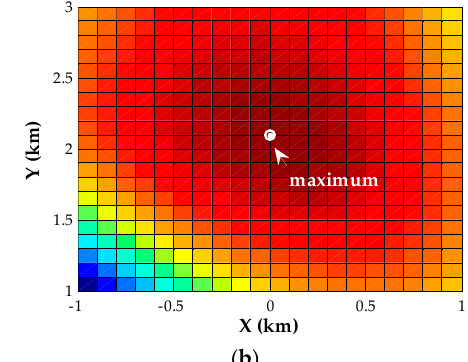
Figure 1. Scenario of three observers and two near-field sources placed on the ground .